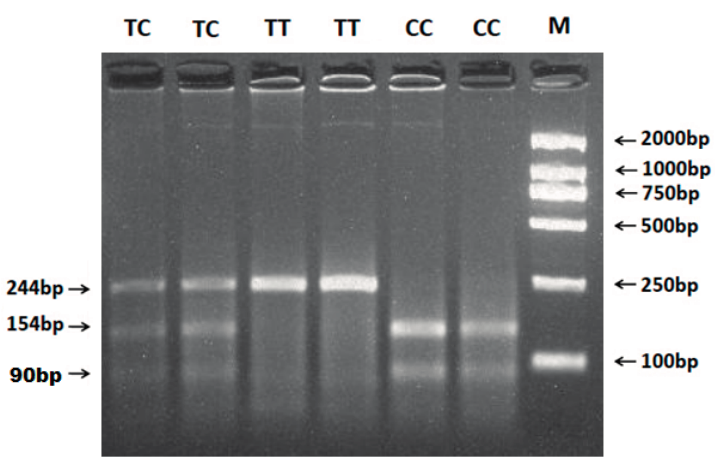
Figure 3. PCR-RFLP results of different genotypes of the PCR products digested by enzyme BsiE I g.47C>T of ovine FSHR polymorphisms. The genotypes are marked on the top of the lanes. M: DNA Marker